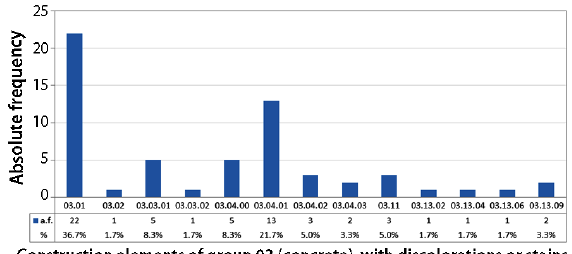
Fig. 29. Absolute frequency (a.f.) and percentage of specific construction elements belonging to group 03 – concrete elements with discolorations or stains (A3)